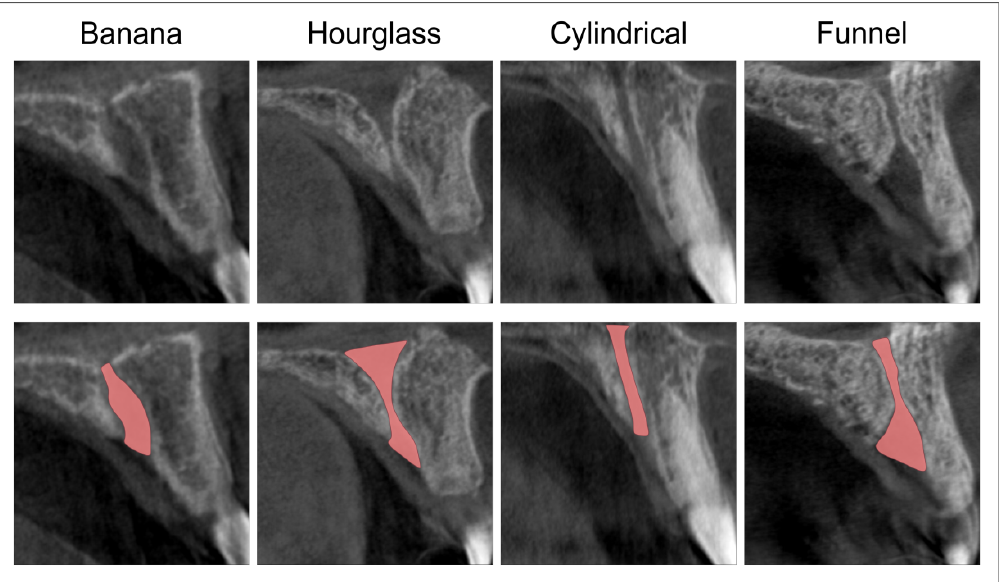
Figure 1. The NPC types and marks of interest. Upper: Sagittal CBCT cross-sections; bottom: red marks define NPC types.